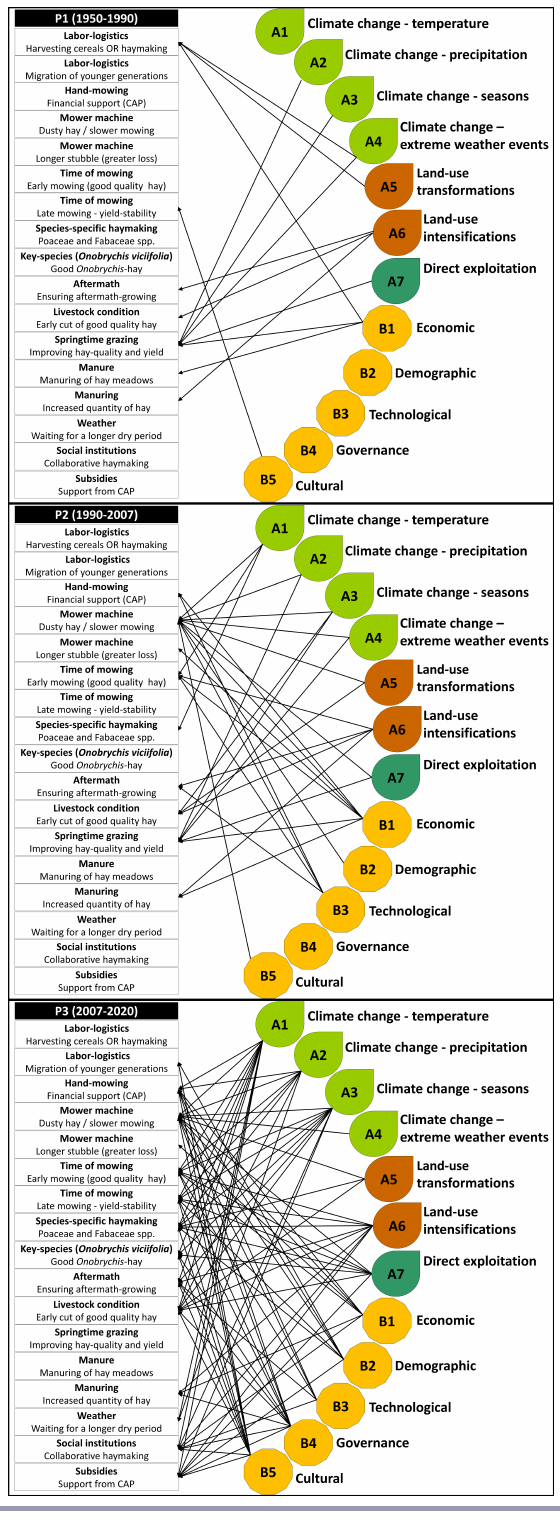
Fig. 7 . Increasing number of direct and indirect drivers and trade-offs regarding the timing of mowing on hay meadows in the studied periods since the 1950s in Gyimes, Eastern Carpathians, Romania. Key: green: direct driver–climate change; brown: direct driver–land use change; blue: direct driver–direct exploitation; yellow: indirect drivers–economic, demographic, technological, governance, and cultural